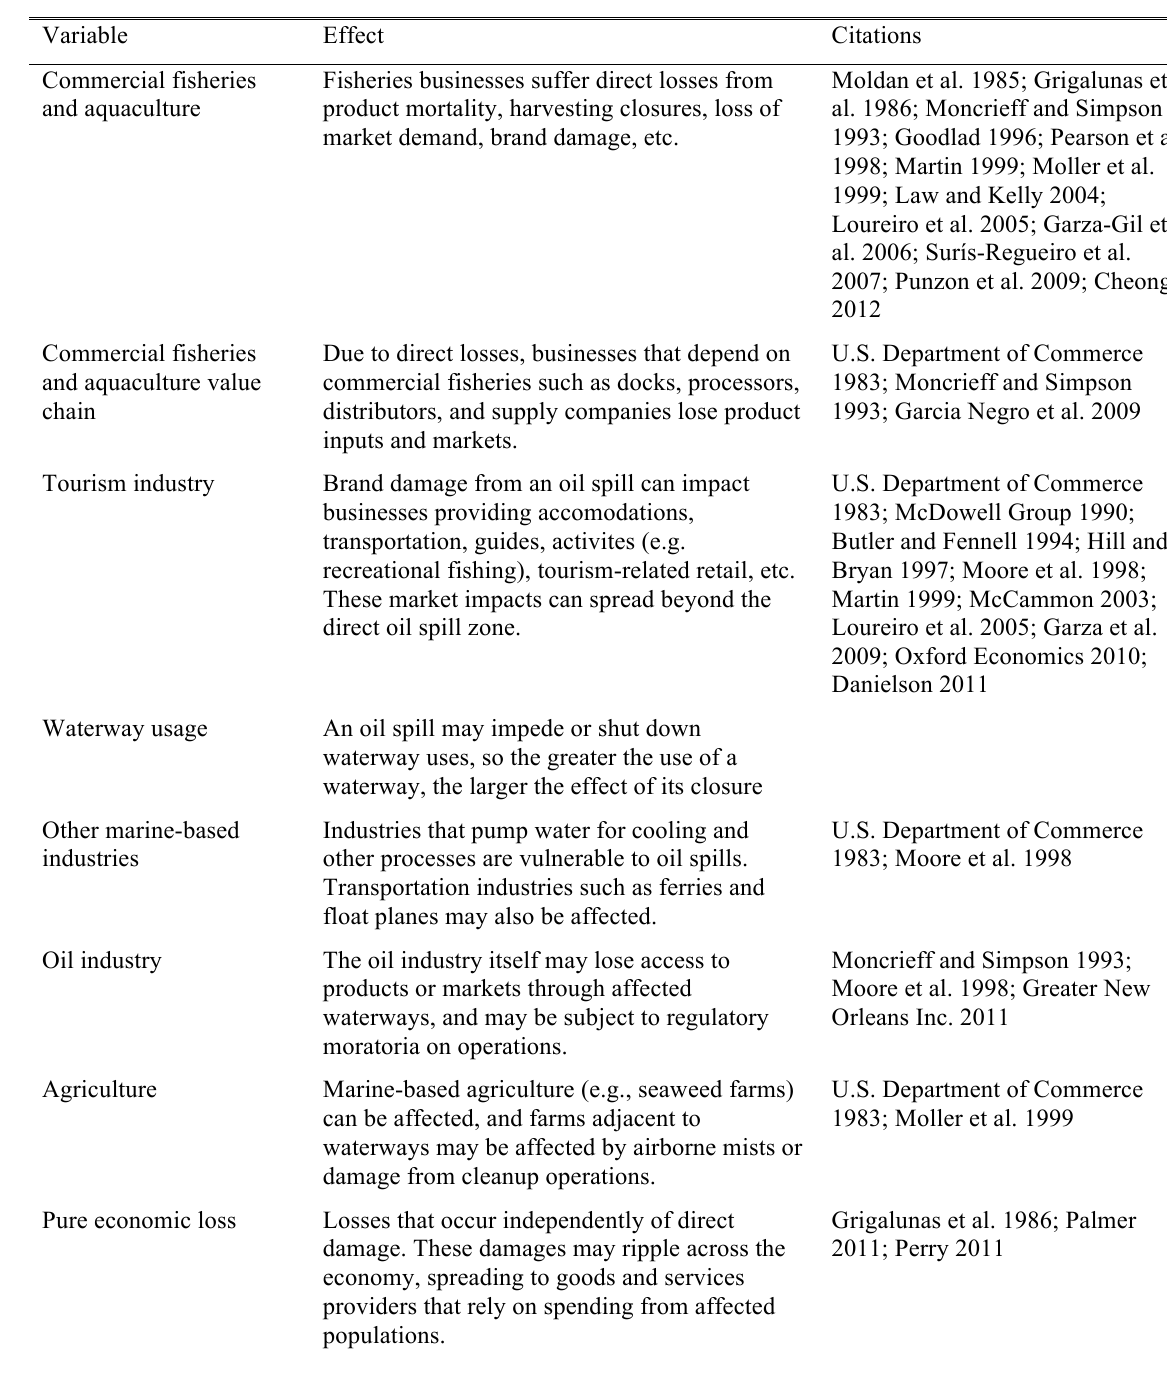
Table A1.6 Economic